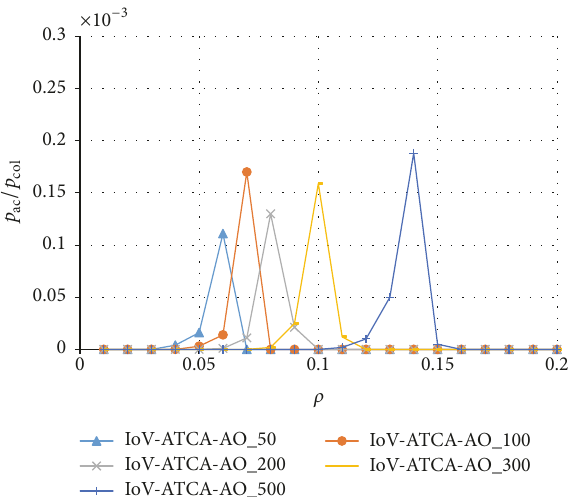
Figure 8: Effect of various 𝑑 1